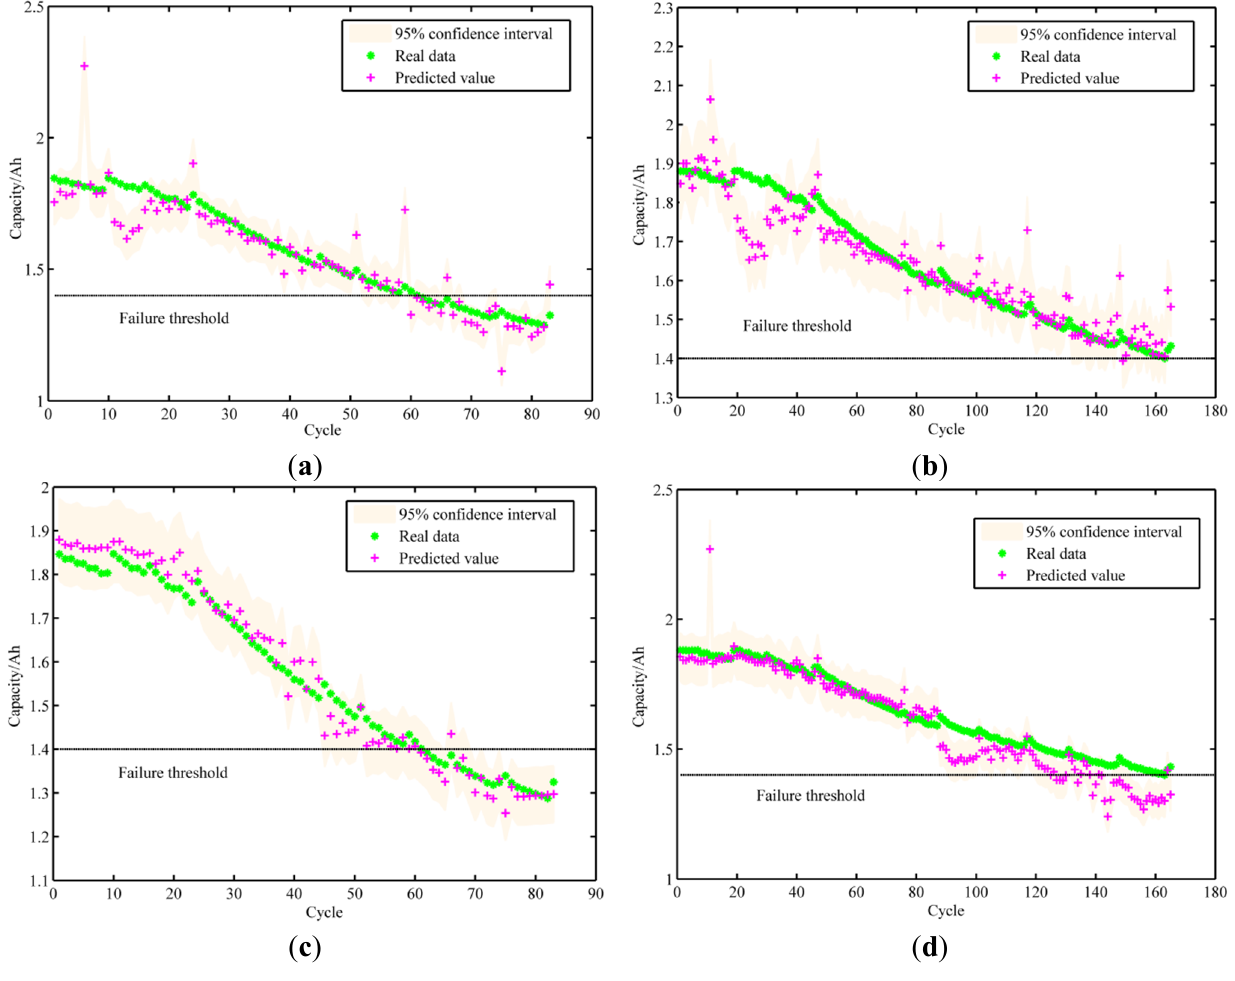
Figure 5. Comparison between the results obtained from the results of the SVR and F-SVR methods at an ambient temperature of 24 °C. Predictive results of the SVR method for: ( a ) Battery No. 5’s odd-number cycles; and ( b ) Battery No. 7. Predictive results of the F-SVR method for: ( c ) Battery No. 5’s odd-number cycles; and ( d ) Battery No.